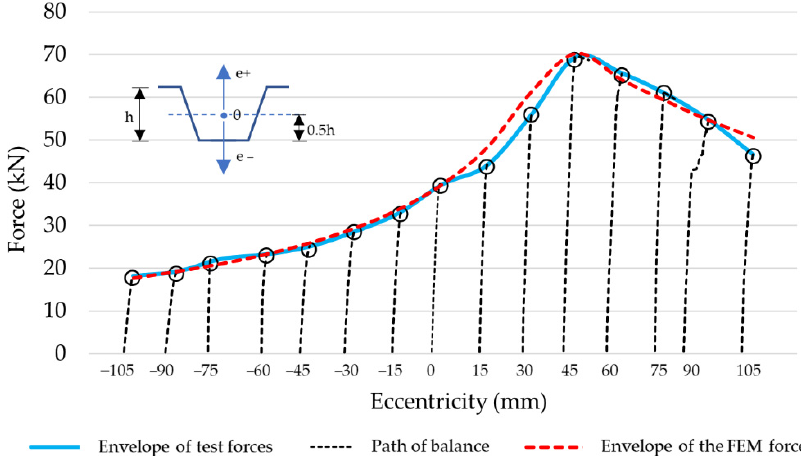
Figure 8. The graphical representation of the FEM versus the experimental test results at different eccentricities of compressive force.